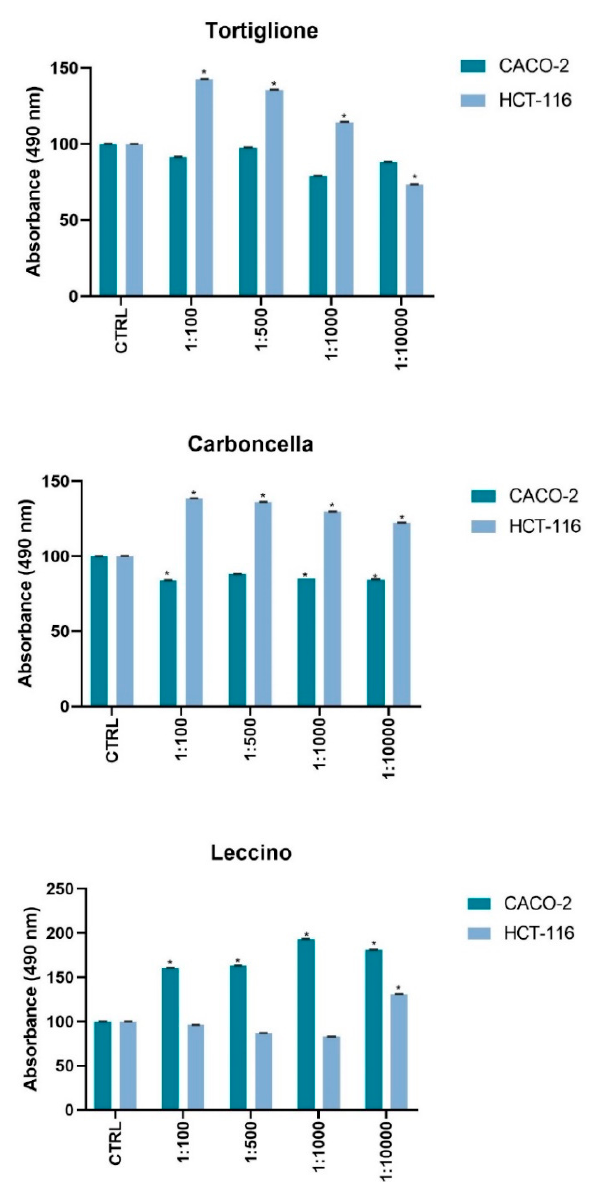
Figure 5. Cell viability and metabolic activity was tested using a colorimetric assay MTS Caco-2 and HCT116 (1.0 × 10 4 cells/well) were exposed to an increasing dilution (from 1:100; 1:500; 1:1000; 1:10,000) of dried extracts from 1mL Olea europaea L. cvs. Leccino, Carboncella and Tortiglione olives at 72 h of times. For each experiment n = 5 replicates wells were assayed per clone. Cell viability values were calculated as means and compared to untreated proliferant cells (CTRL). * p < 0.001 vs. untreated cells.